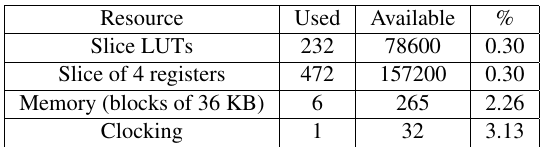
Resources usage of the FAST detector design